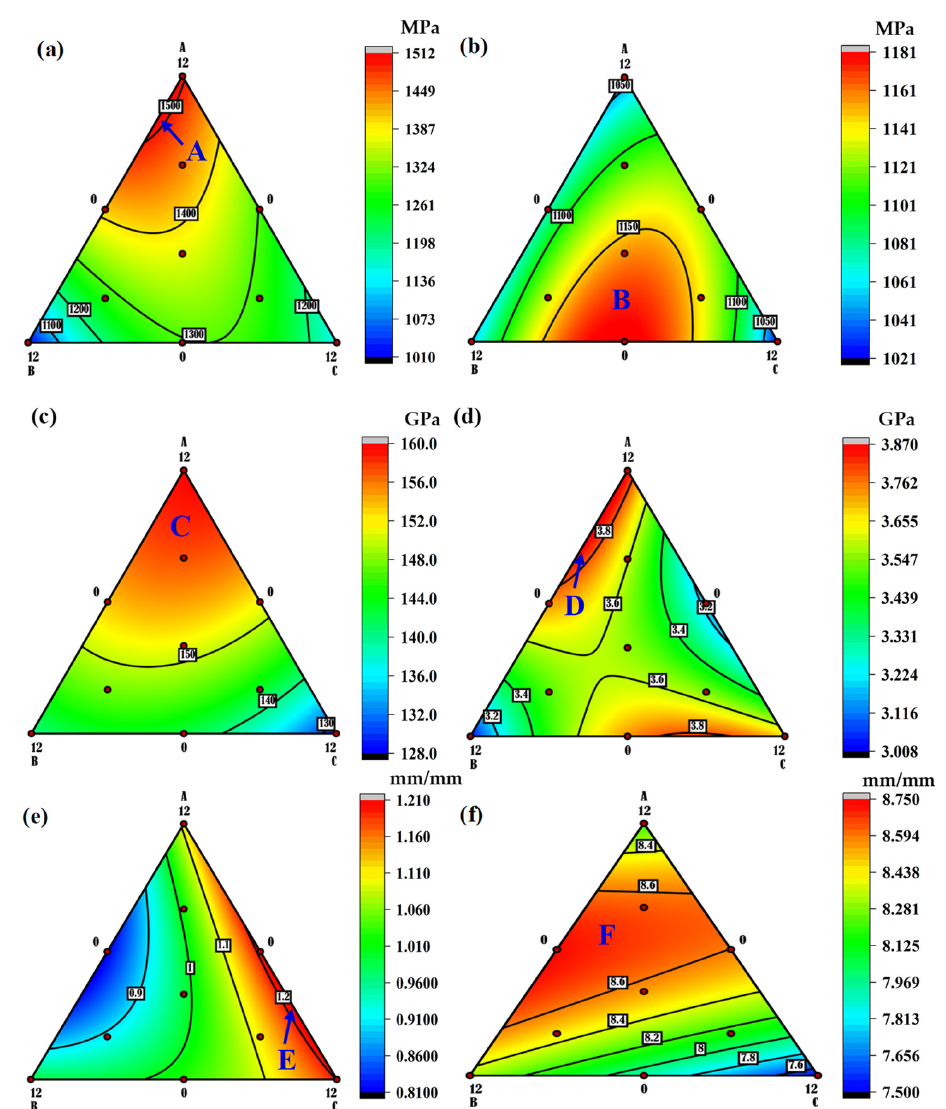
Figure 7. Ternary plots for response parameters: ( a ) tensile strength, ( b ) compressive strength, ( c ) elastic modulus, ( d ) hardness, ( e ) elastic strain, and ( f ) compressive Table 4. Parametric range for desirable objectives.